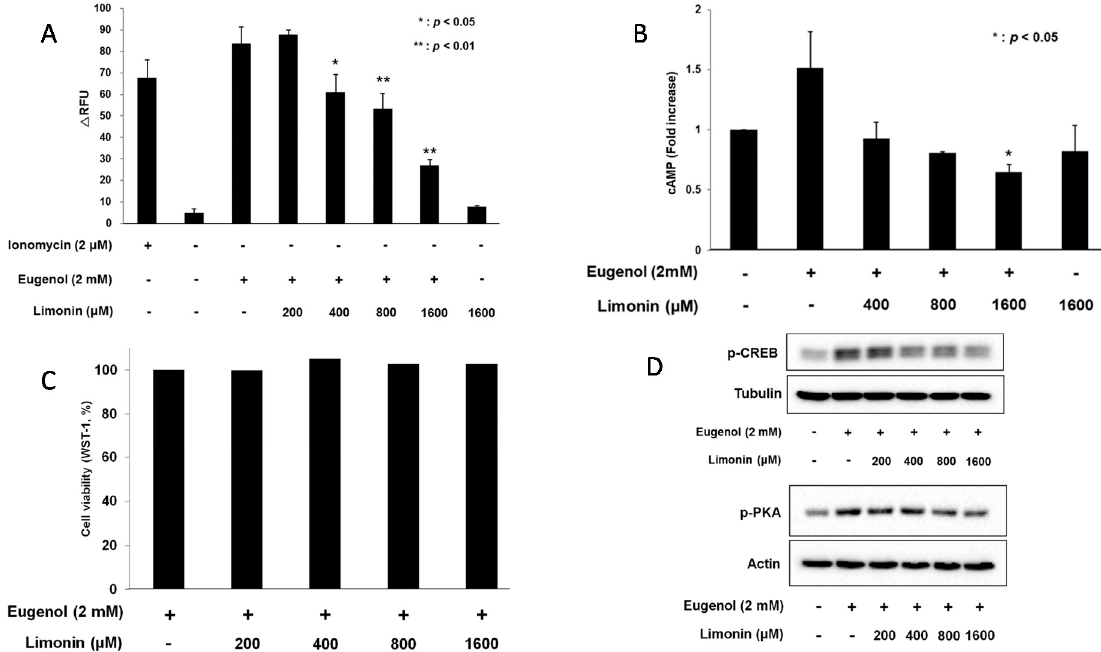
Figure 4. ( A ) Changes of Ca 2+ levels with limonin pretreatment in eugenol-induced 3T3-L1 cells. Ionomycin (2 μ M) and DMSO (0.2%) were used as positive and negative controls, respectively. The data are shown as means ± SD ( n = 3). *: p < 0.05, **: p < 0.01, Δ RFU: change in relative fluorescence unit; ( B ) Pretreatment with limonin for 30 min changes cAMP levels in eugenol-induced 3T3-L1 cells. The final concentration of DMSO was 0.2%. The data represent means ± SD ( n = 3). *: p < 0.05; ( C ) Cell viability. 3T3-L1 cells were treated with limonin for 30 min. Cell proliferation was evaluated by WST-8 assay. The data are shown as means ± SD ( n = 3); ( D ) Phosphorylated protein kinase A (PKA) and cAMP response element binding protein (CREB) levels in 3T3-L1 cells after pretreatment with limonin for 30 min. A total of 35 μ g of protein was separated by SDS-PAGE. In experiments for Western blot analysis, the final concentration of DMSO was 0.2%.